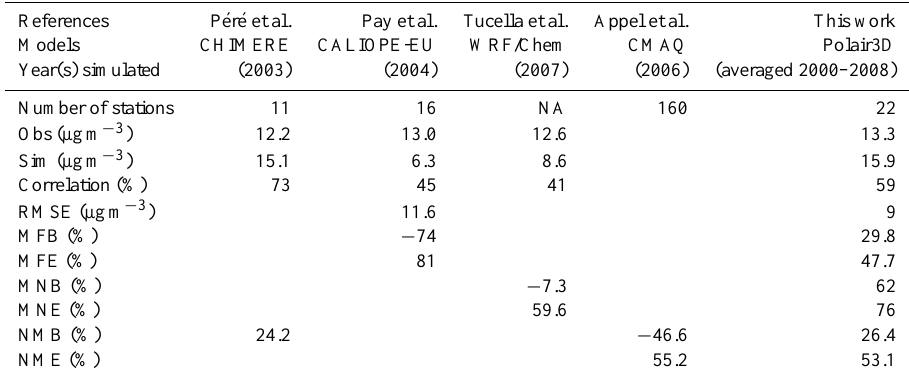
Table B1. Comparison for PM 2 . 5 with P´er´e et al. (2010), Pay et al. (2010), Tuccella et al. (2012), and Appel et al. (2012). The data from this work are averaged over 2000–2008.